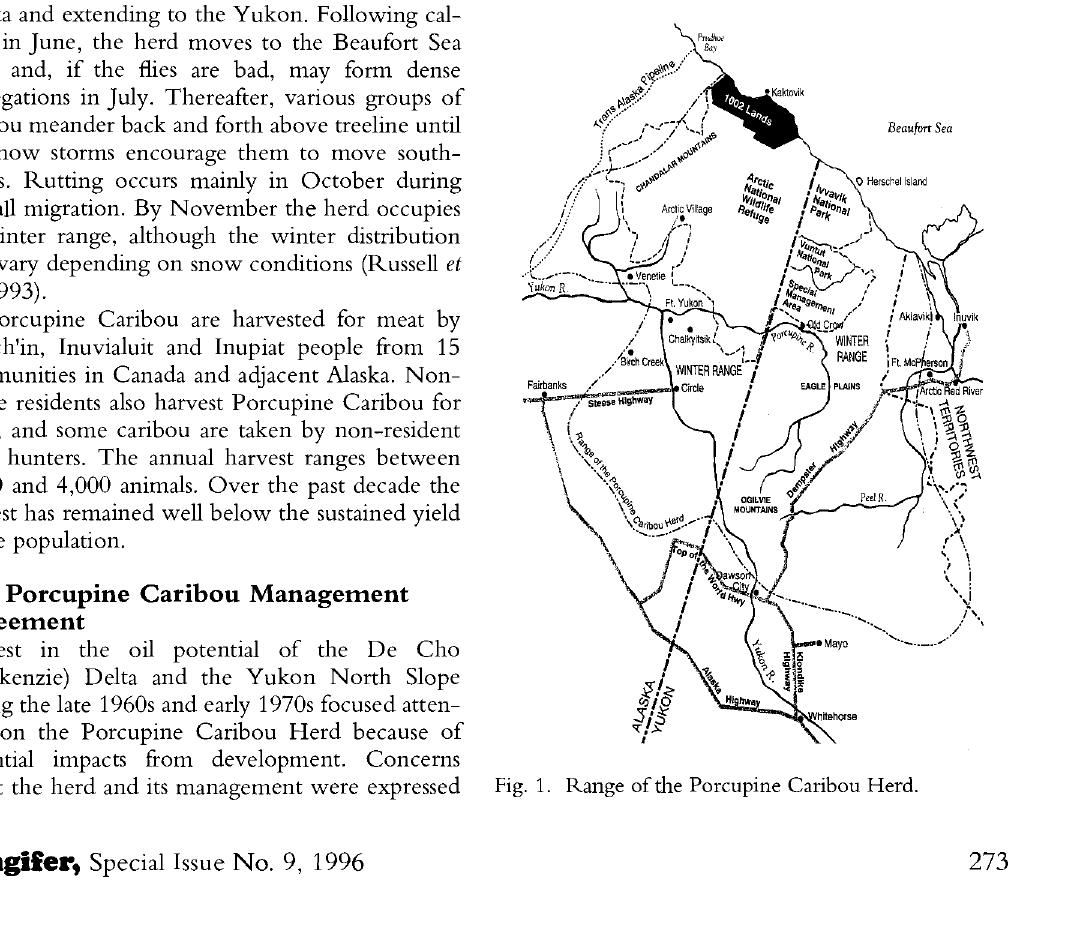
Fig. 1. Range of the Porcupine Caribou